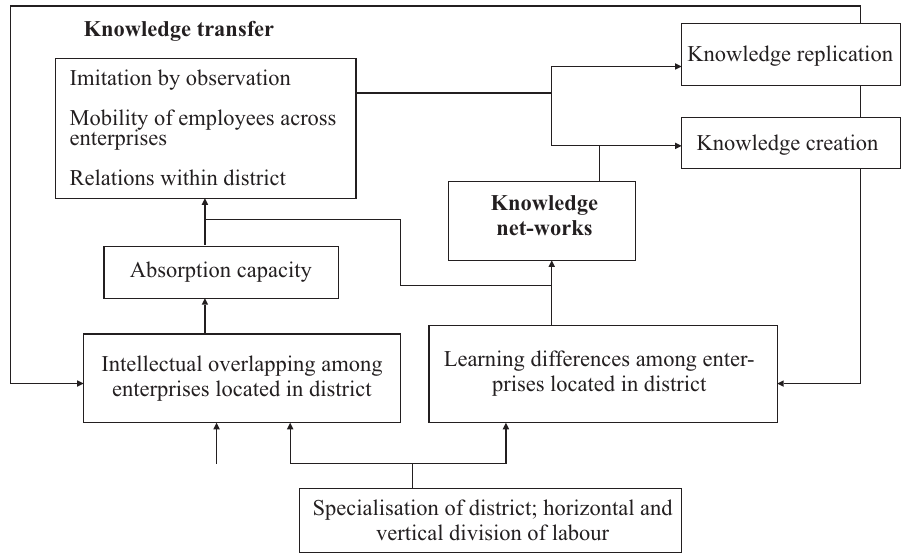
Figure 2. Knowledge creation and knowledge networks in local economic